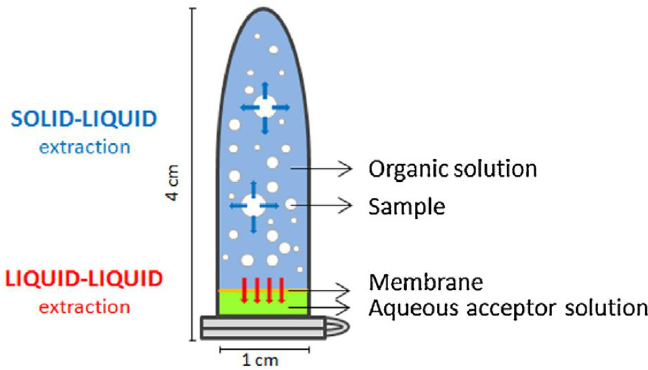
Figure 7. Device for stir membrane solid-liquid-liquid extraction. Reproduced with permission from [37], copyright Elsevier, 2014.